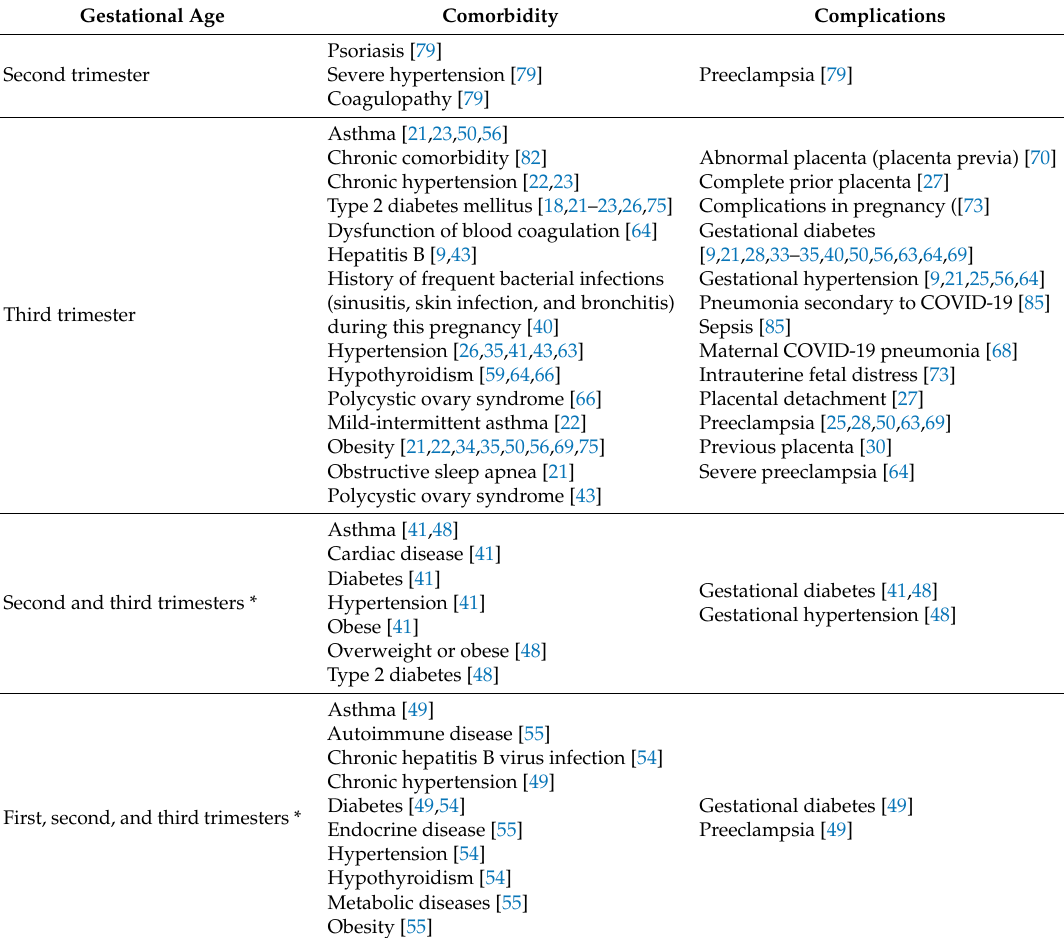
Table 2. Comorbidities and complications in pregnant women diagnosed with